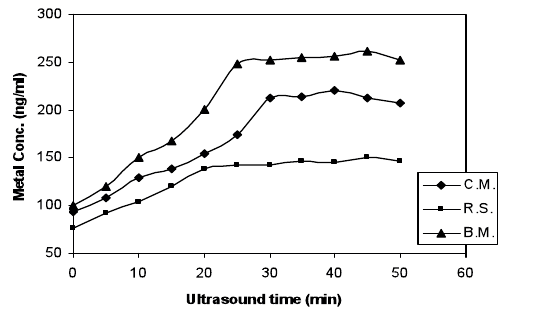
Figure. 1. Effect of sonication time on iron recovery from CAFM samples (B.M. = beet molasses, C.M. = cane molasses, R.S. = raw sugar).